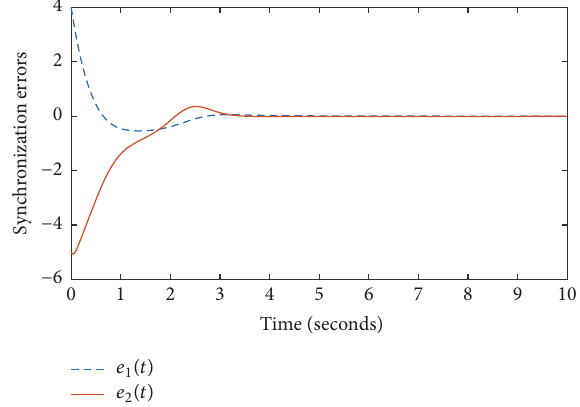
̂𝜁 (𝑡) . Figure 4: Time response of synchronization errors 𝑒 1 (𝑡) and 𝑒 2 (𝑡) . 1